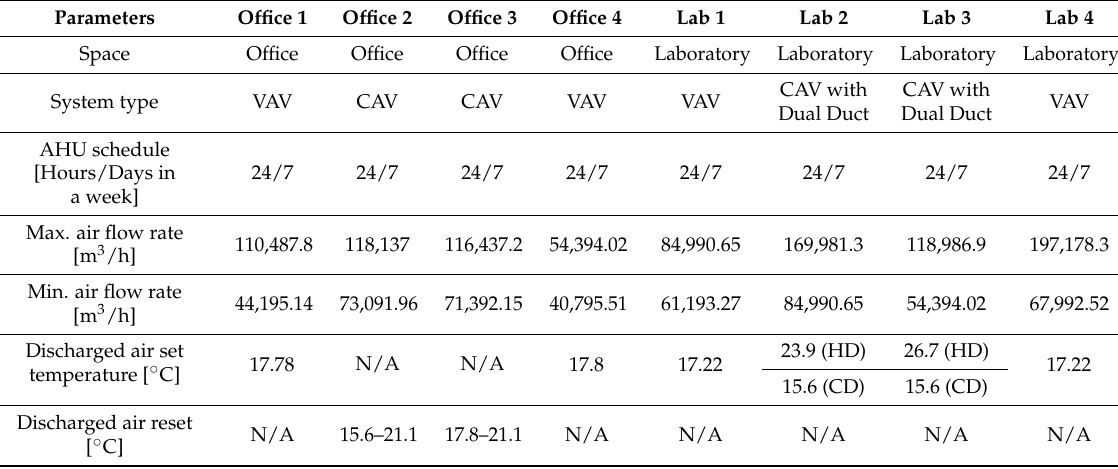
Table 3. Air handling unit models for the offices and